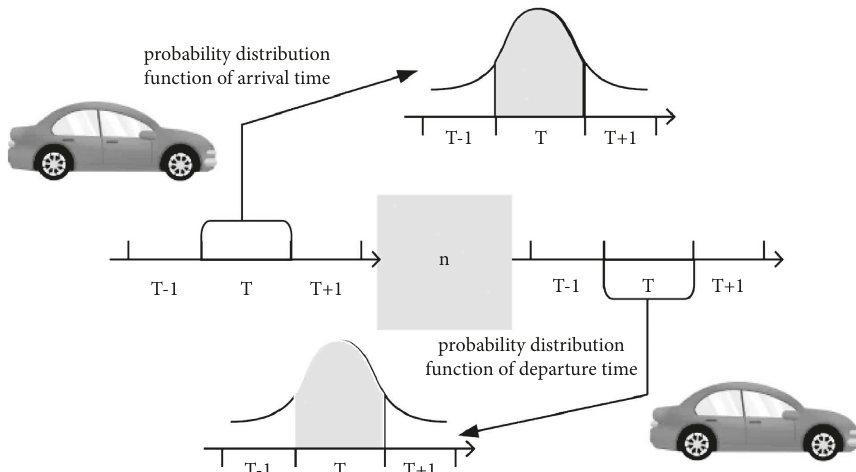
Figure 2: Probability distribution of the arrival/departure time of vehicles in cell n